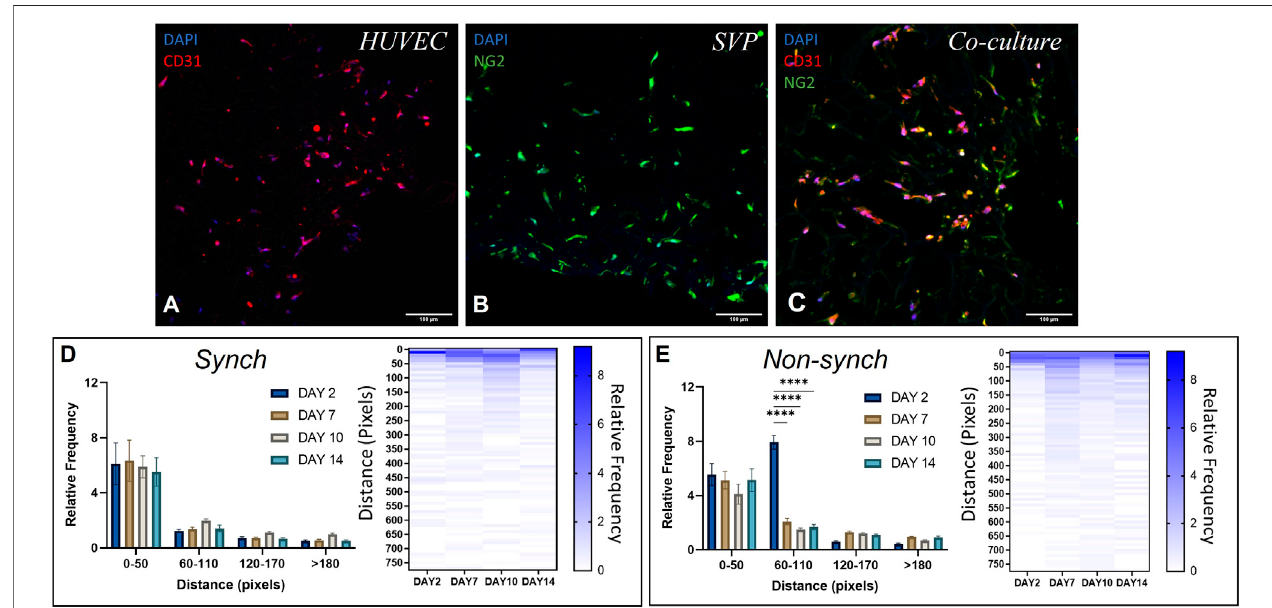
FIGURE 5 | Distribution of endothelial cells and pericytes in a 3D polyurethane scaffold. Representative immuno fl uorescence images of scaffolds seeded with human umbilical vein endothelial cells (HUVEC, (A) ), saphenous vein pericytes (SVP, (B) ) and a co-culture of HUVEC and SVP (C) . CD31 (red), NG2 (green) and DAPI (blue). Scale bar:100 µm. Quanti fi cation of relative cell distribution in the scaffold, in synchronized (synch, (D) ) and non-synchronized (non-synch, (E) ) co-cultures. Heat maps show the relative frequency up to 750 pixels of distance. Data were analyzed using two-way ANOVA, and **** = p <